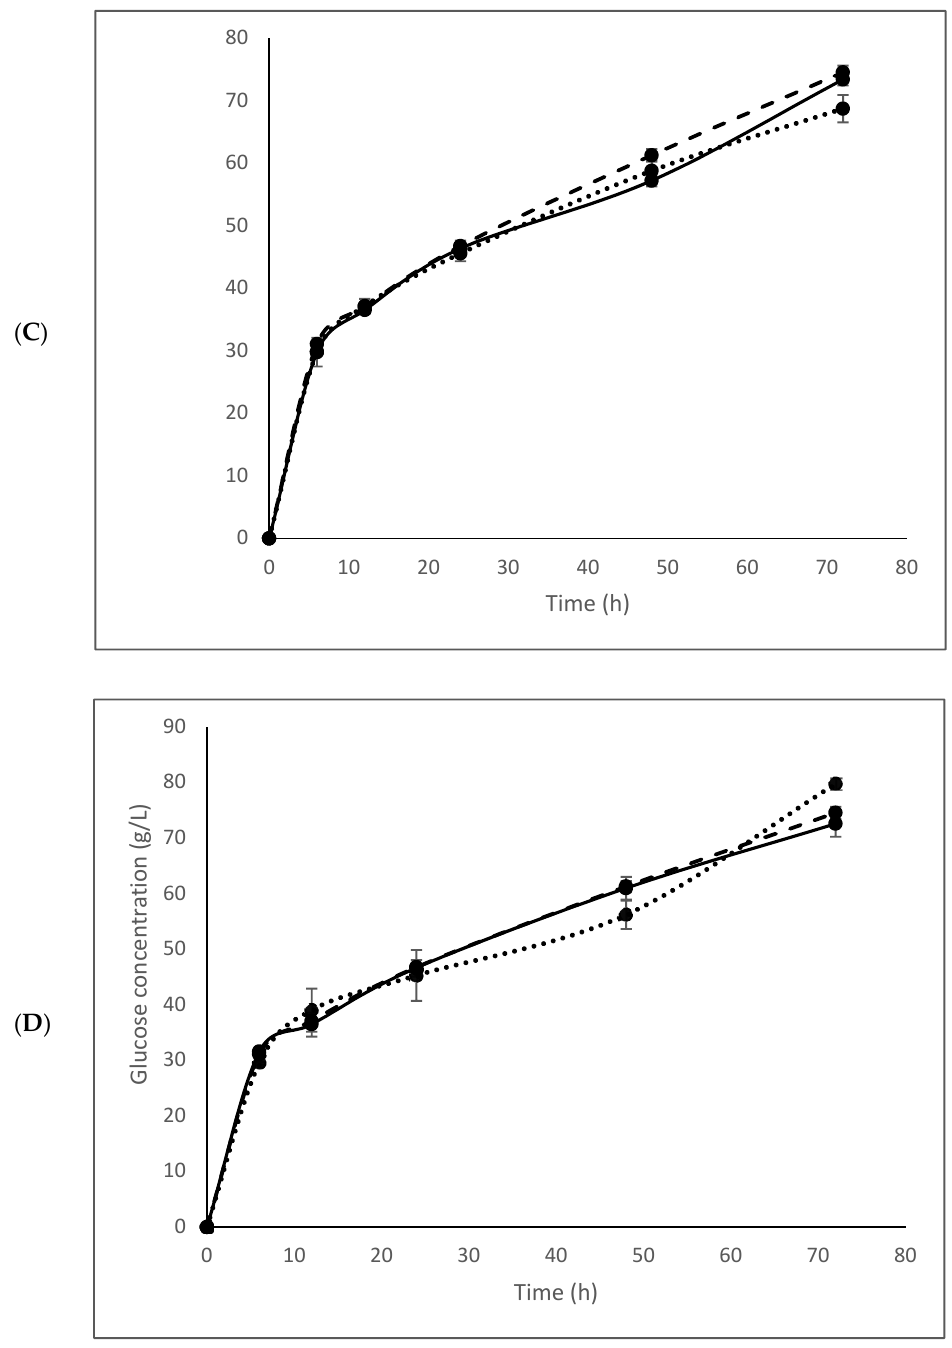
Figure 5. Enzymatic hydrolysis kinetics for surfactant screening. ( A ) Tween 20; ( B ) Tween 80; ( C ) Span 80; ( D ) PEG 400. (—) 0.02 g surfactant/g substrate; ( ··· ) 0.1 g surfactant/g substrate; (- -) Control.